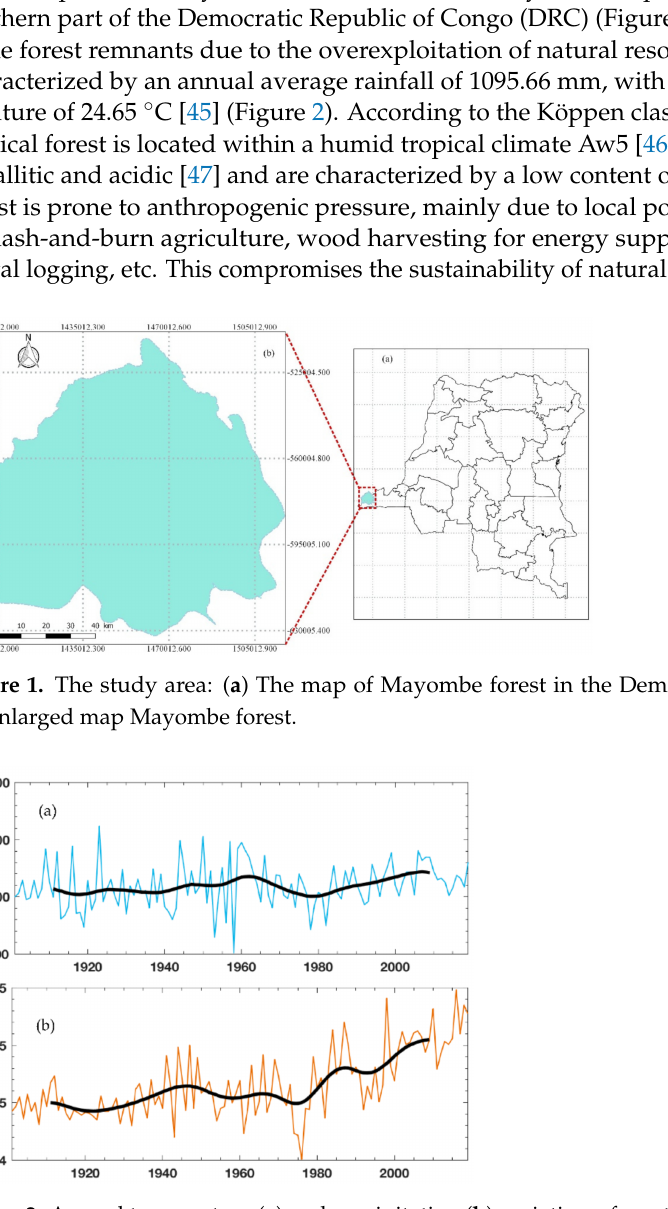
Figure 2. Annual temperature ( a ) and precipitation ( b ) variations, from the year 1901 to 2019